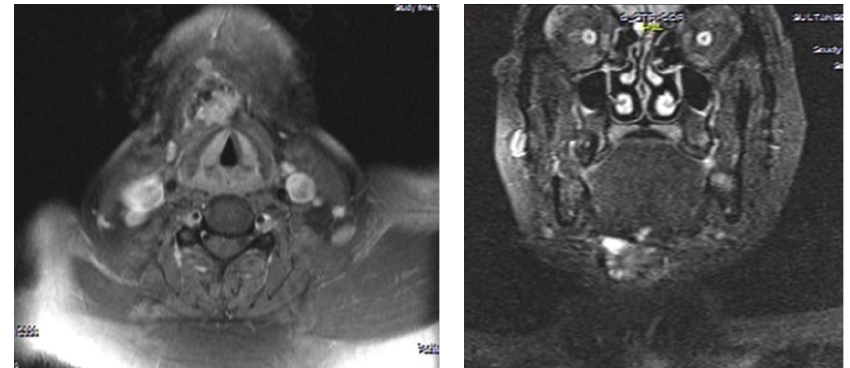
Figure 1: Axial and coronal section MRI demonstrating a solid soft tissue mass containing high signal hyperintensity, cystic changes, and invasion of the infrahyoid muscles.